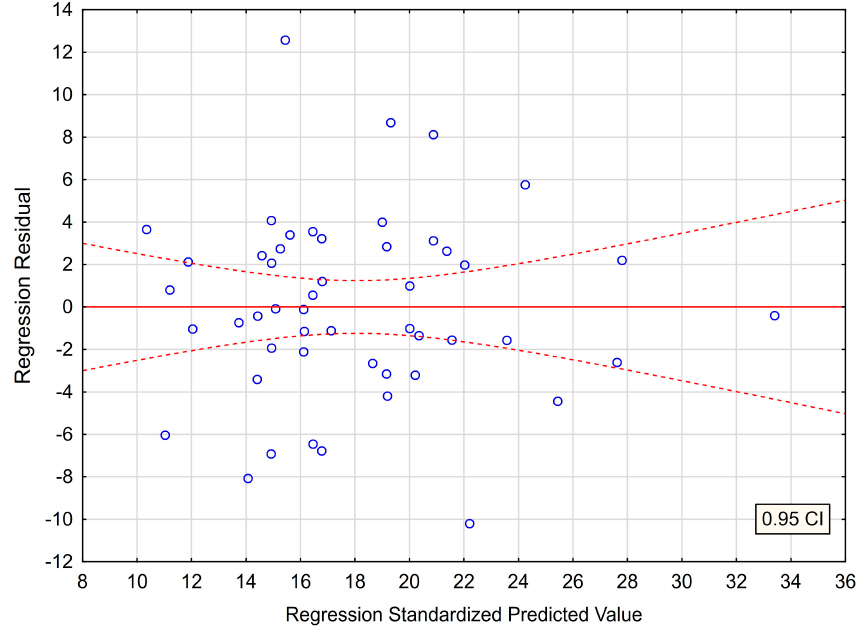
Figure 1. The plot of standardized residues versus standardized predicted values. (homoscedasticity) with respect to multiple regression model for PSS − 10.